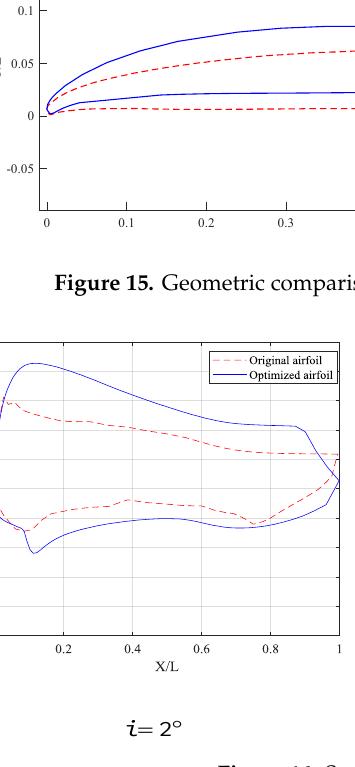
Figure 16. Surface pressure distributions.